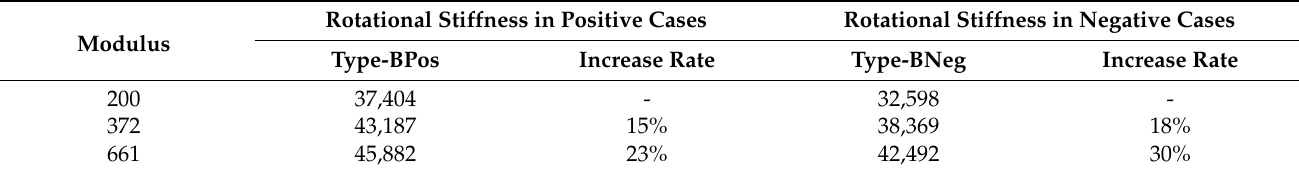
Figure 23. Evolution of the rotations and bolt stresses with different Young’s moduli: ( a ) rotation curves; ( b ) bolt stress curves. Table 8. Summary of the rotational stiffnesses during the third stage with different moduli of the bolts (stiffness unit: kN·m/m/rad, modulus unit: GPa).